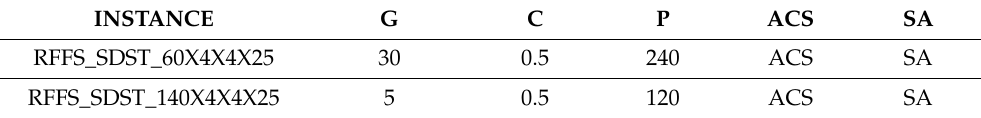
Table 6. HGAG tuning results.